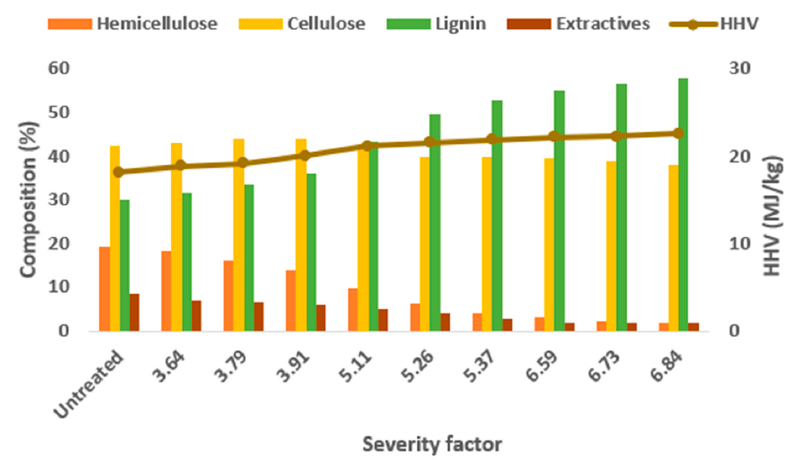
Figure 6. HHV and chemical composition of untreated and treated